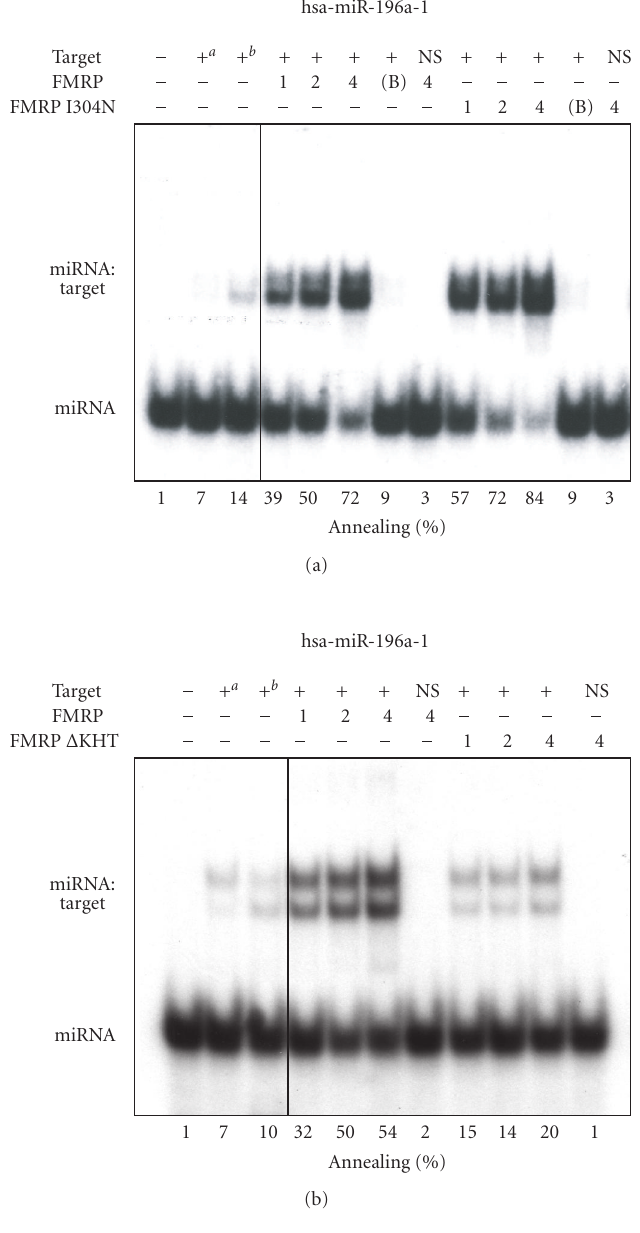
Figure 3: FMRP mediates miRNA annealing to specific RNA targets through its KH domains. RNA strand annealing properties of the FMRP I304N (a) and Δ KHT (b) mutants. (a) 32 P-labeled hsa-miR-196a-1 miRNA was incubated with a specific HOXB8 RNA target in the absence or presence of FMRP or FMRP I304N or with BSA at 4 : 1 (protein:RNA) molar ratio. (b) The RNA strand annealing assays using the FMRP Δ KHT mutant were performed as in (a). Control hybridization was conducted at 37 ◦ C for 10 min a or 65 ◦ C for 30min b . RNA complexes were analyzed by nondenaturing 10% PAGE and autoradiography. B, BSA; NS, nonspecific lin-41 RNA